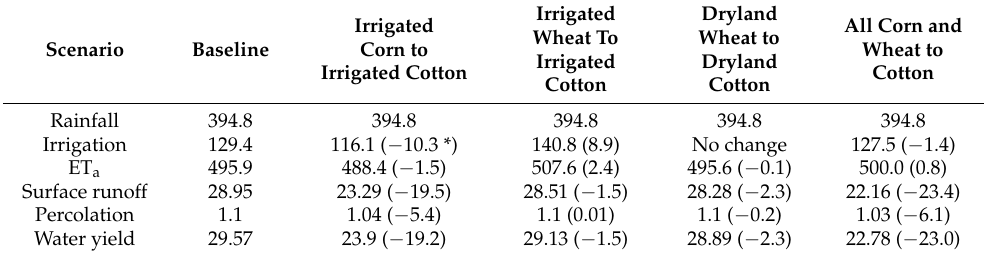
Table 5. Comparison of the average (2000–2014) annual water balance parameters (mm) under baseline and land-use change scenarios in the entire Palo Duro